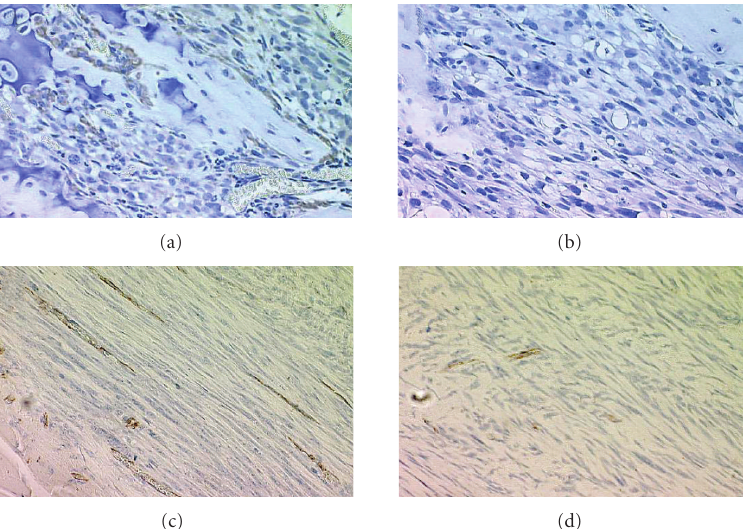
Figure 3: Immunohistochemical staining of the orthotopic osteosarcoma models. Micrographs (a) and (c) were tumors derived from high VEGF G-292 cells; while (b) and (d) were samples from HOS cell transplantation. (a) and (b) were stained with antihuman VEGF antibodies; and (c) and (d) were against antihuman CD31.